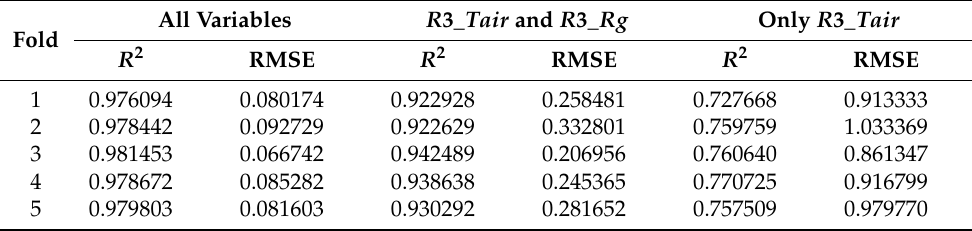
Table 6. Cross-validation results for the three scenarios.